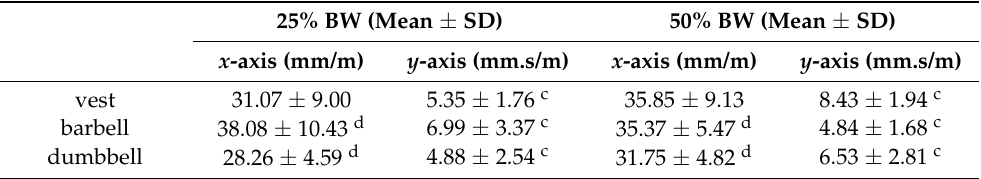
Table 3. COP x -axis offset range and y -axis offset at 25% BW and 50%